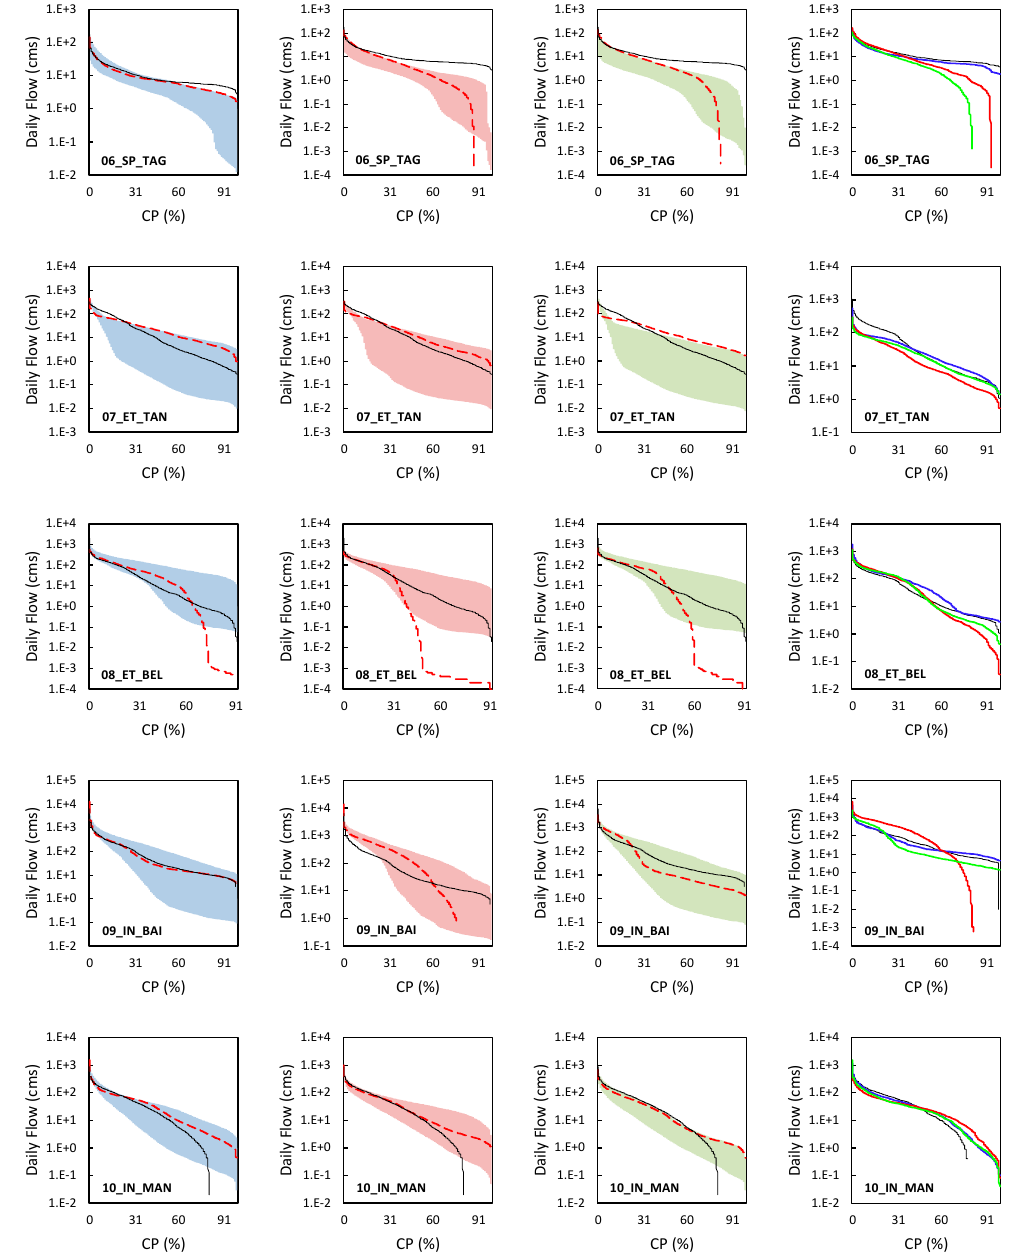
Figure 7. Daily Cumulative Probability plot for daily streamflow using each of the three rainfall inputs. The graph with the uncertainty range (95 ppu) it refers to the calibration process (local data, CFSR, and CHIRPS, respectively), the red dotted line indicates the best simulation, and the black dots are the observed data. The validation process is represented by the graph with no 95 ppu envelope, the black dots are the observed data, the blue line is the local data, the red line is CFSR, and the green line is CHIRPS. (For interpretation of the references to color in this figure legend, the reader is referred to the web version of this article.). The results of SWAT calibration at a daily scale for the 01_US_IOW watershed with a p factor value of 0.43 and an r factor value of 0.79 for CHIRPS data show larger uncertainties. Though the performance of CHIRPS data is better compared to CFSR data, the uncertainty band is wider.